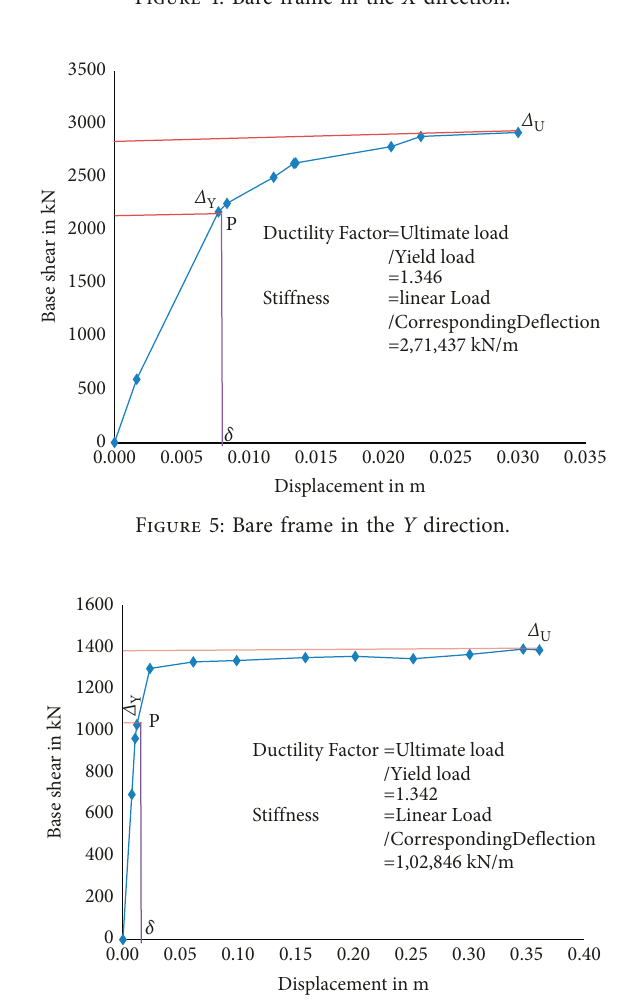
Figure 6: Infill frame in the X